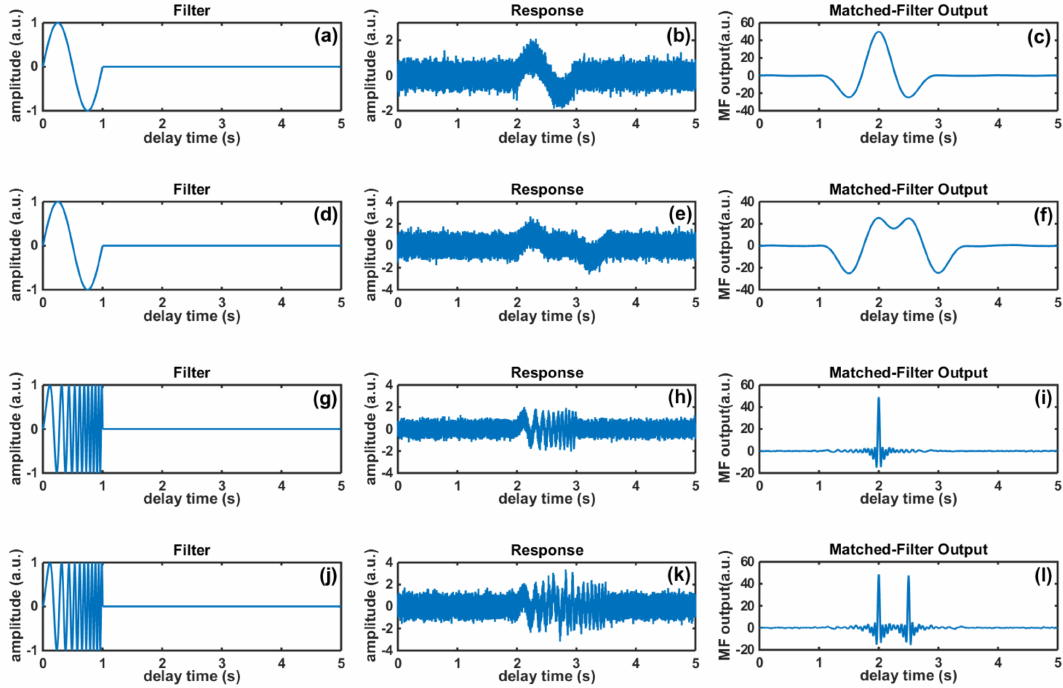
Figure 1. Simulated filter, noisy response, and matched-filter output for: ( a – c ) single-frequency response of a single reflector; ( d – f ) single-frequency response of two reflectors; ( g – i ) Linear frequency modulation (LFM) response of single reflector; LFM response of two